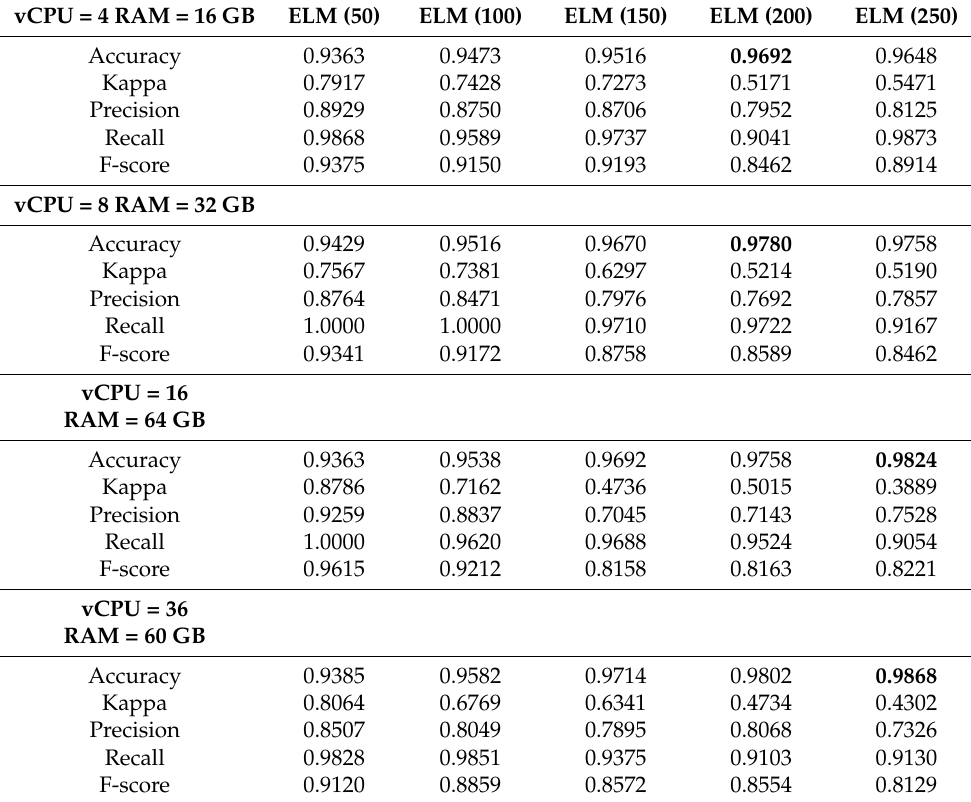
Table 7. Performance analysis of ELM deployed on a cloud computing environment with different numbers of hidden layer nodes. Best accuracy values are shown in